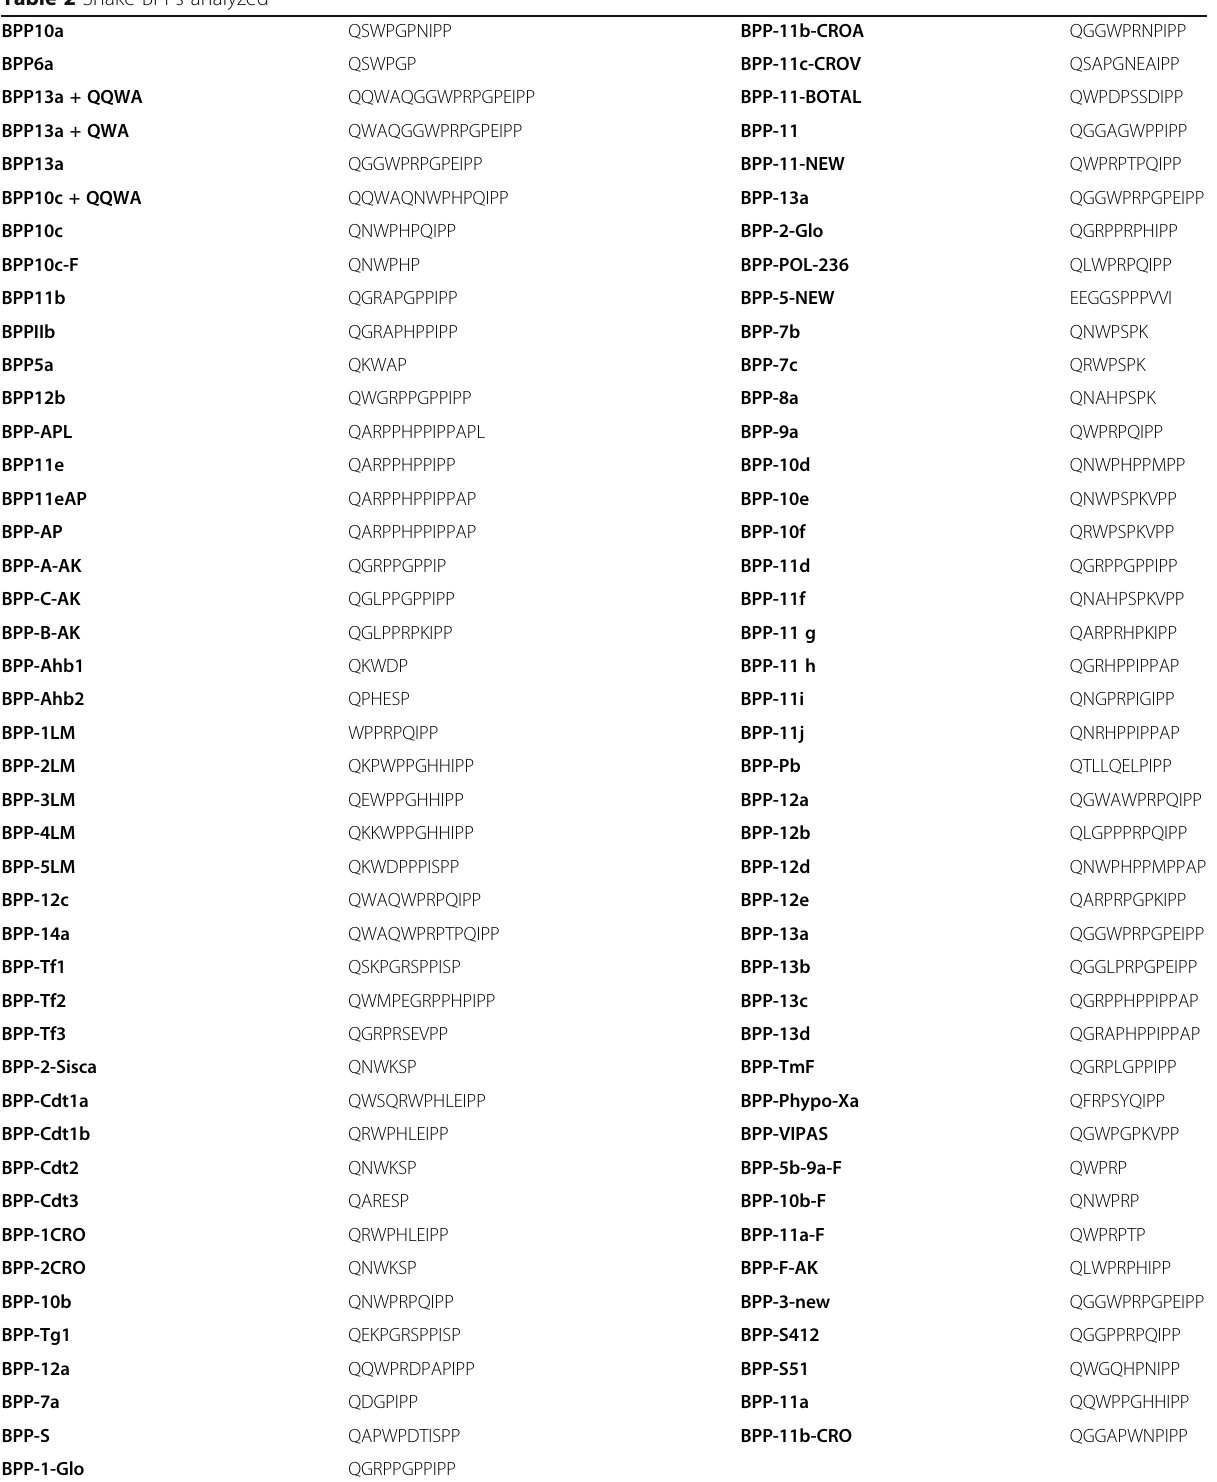
Table 2 Snake BPPs